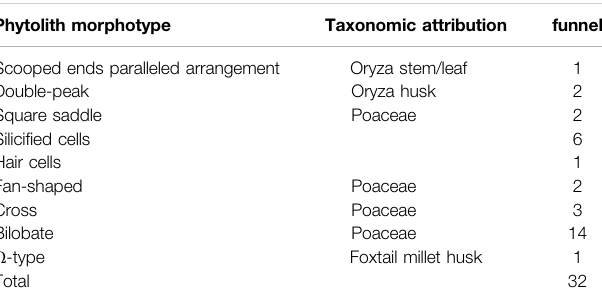
TABLE 2 | Phytoliths from the Qingtai site